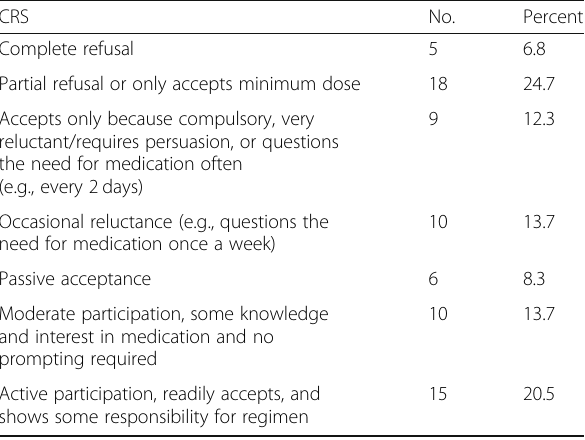
Table 3 Clinician Rating Scale (CRS) among studied patients